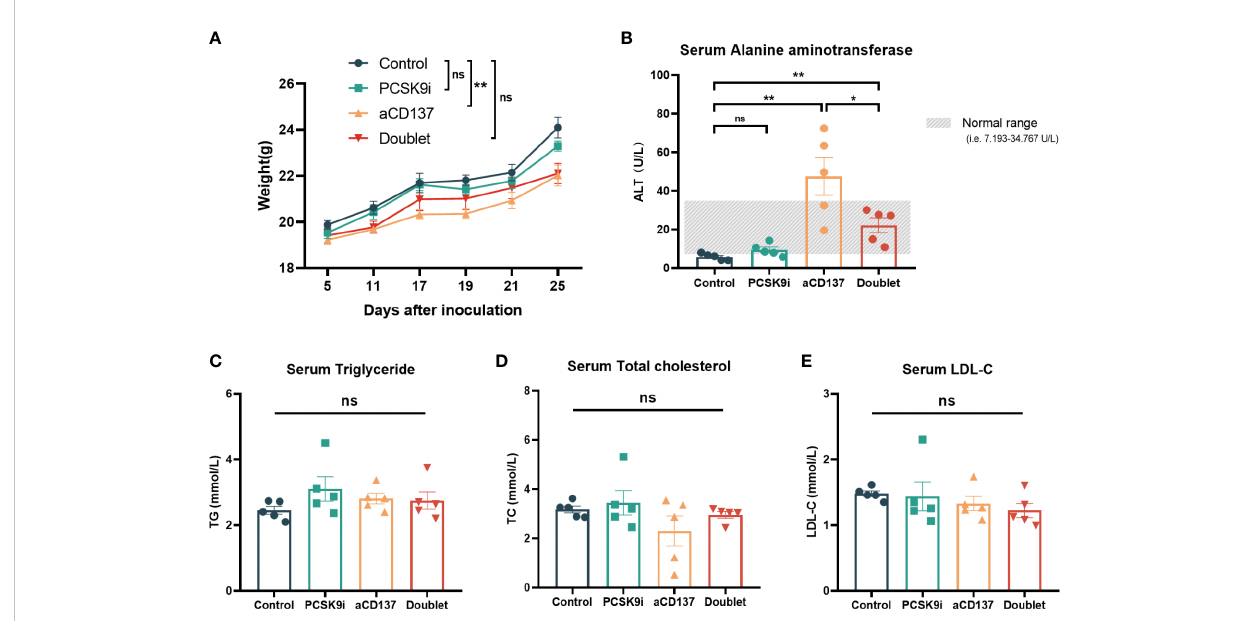
FIGURE 6 Body weight and serological changes of the mouse models after the treatments. (A) Body weight change of mice in each group ( n = 5 per group, two-way ANOVA). (B – E) Serum ALT, TG, TCHO, and LDL-C levels of mice in each group on day 21 ( n = 5 per group, unpaired t -test or the Mann – Whitney test). *ns, No signi fi cant difference, * P < 0.05, ** P <